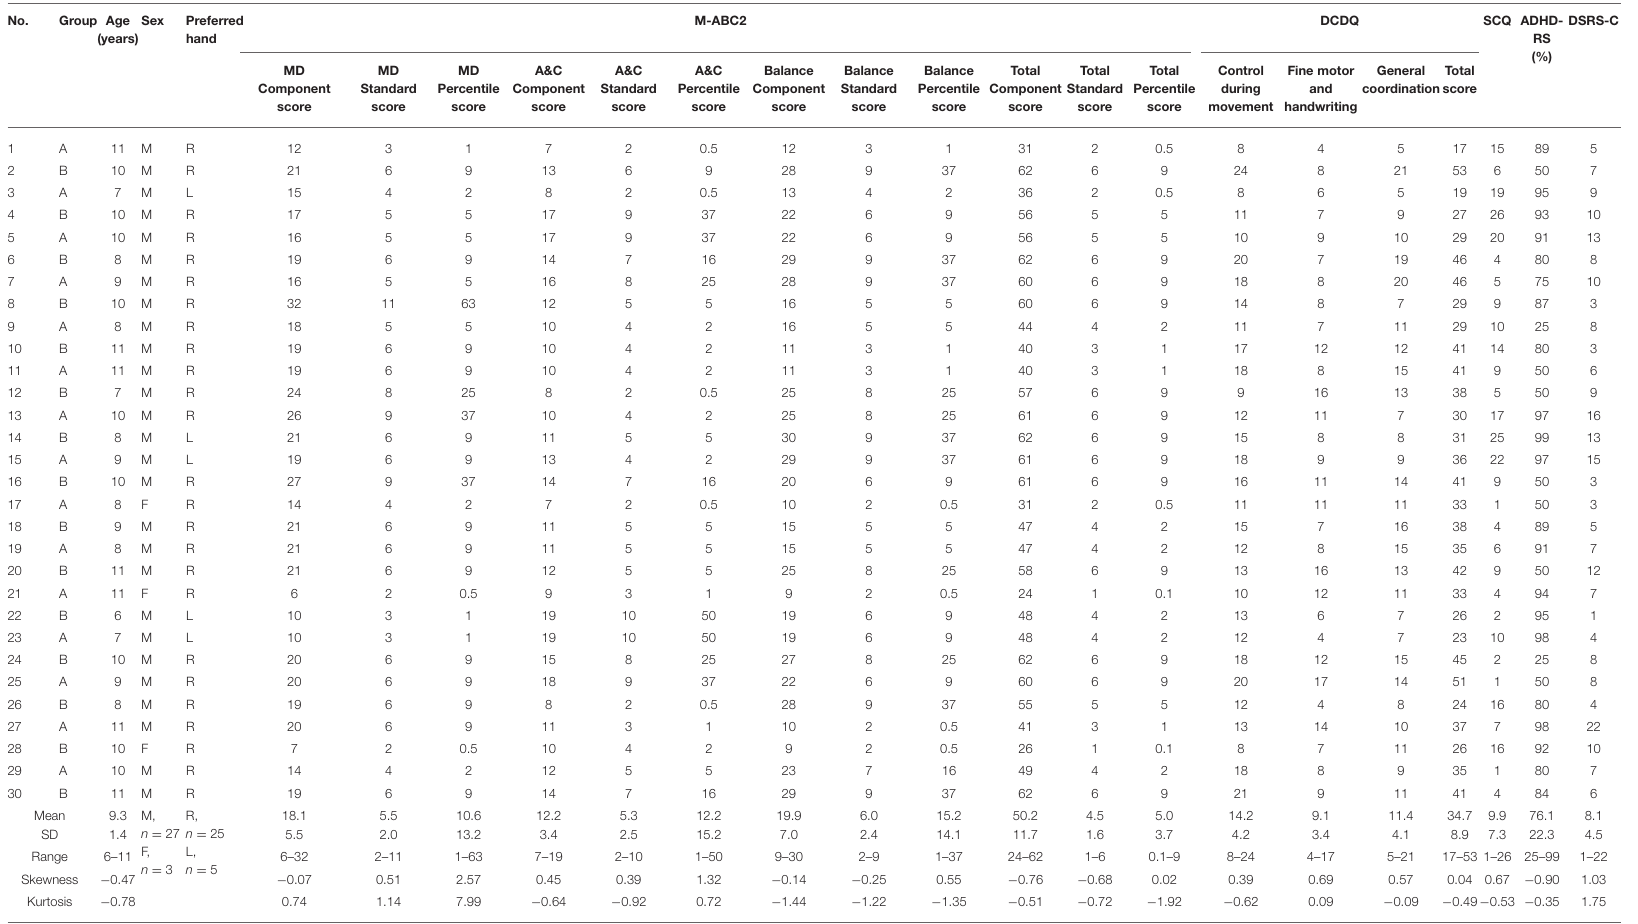
TABLE 1 | Results of tests conducted on the day before the current study (Baseline-data). No. Group Age Sex Preferred (years)